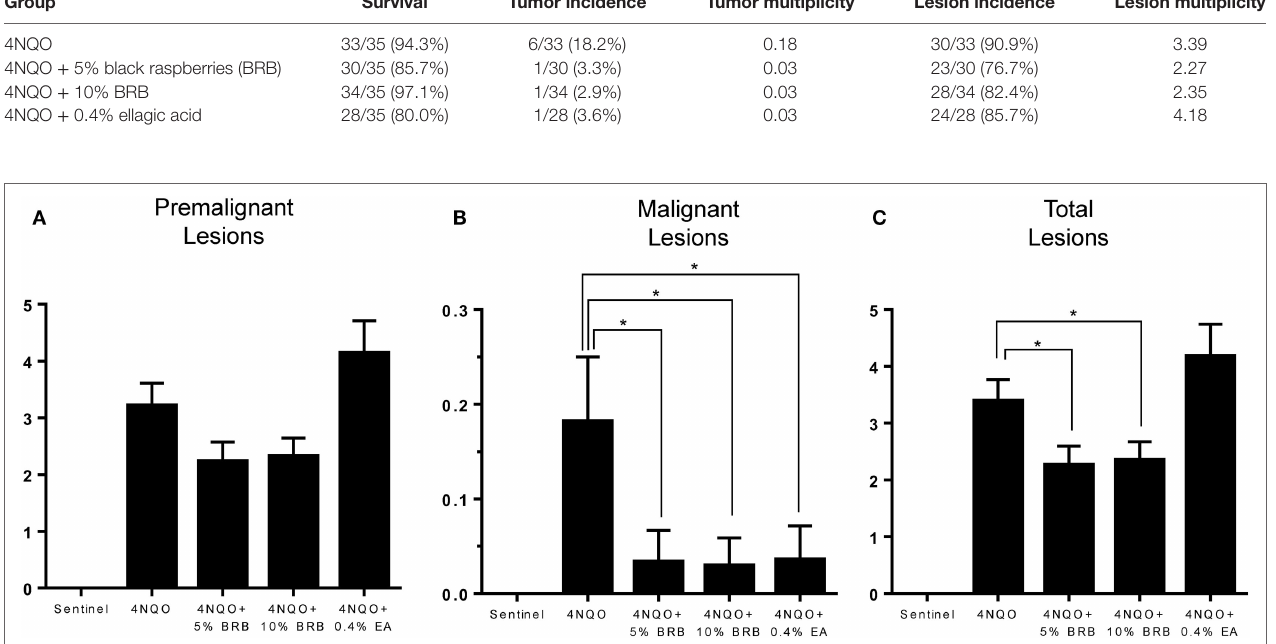
TaBle 1 | Analysis of gross lesions in tongues of rats induced with the oral carcinogen 4-nitroquinoline 1-oxide (4NQO), with or without dietary administration of chemopreventive agent. group survival Tumor